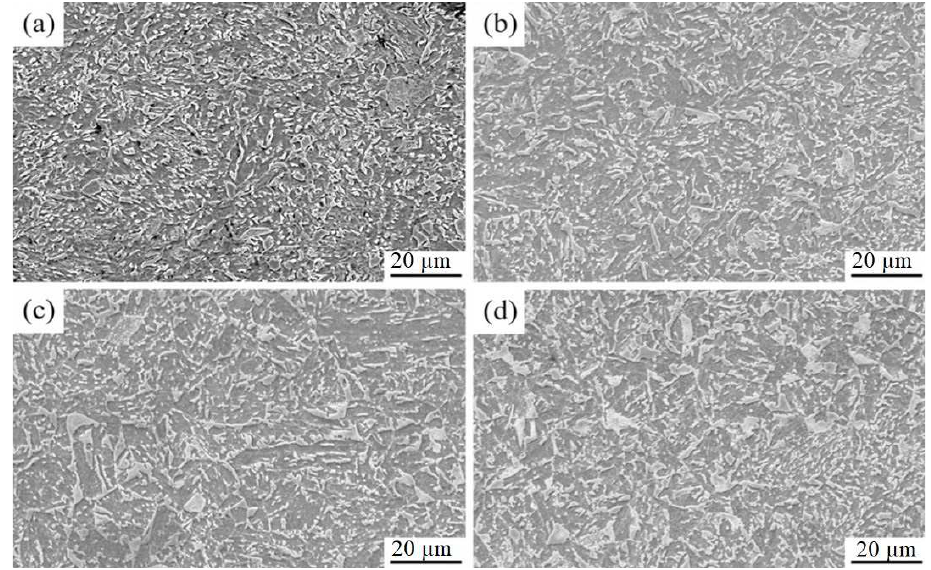
Figure 11. SEM morphology of sub-temperature quenching structure: ( a ) 770 °C, ( b ) 810 °C, ( c ) 830 °C, and ( d ) 850 °C.